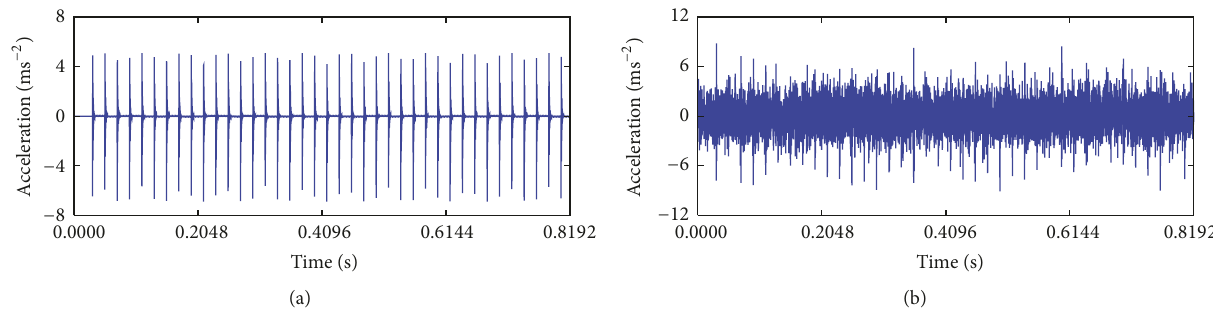
Figure 3: Signals for simulation: (a) the original signals with periodic impulses and (b) the signals with the added white noise (SNR = −7 dB).